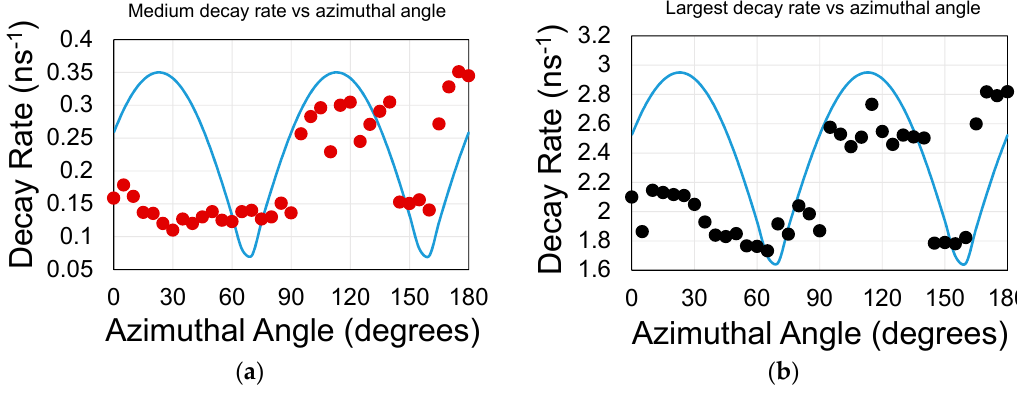
Figure 5. Sample S7. There are essentially two decay rate coefficients: ( a ) below and ( b ) above 1 ns − 1 . The blue line in ( b ) is a guide for the eyes (see SI Section). The curve was shifted by φ 0 since the initial hole-array orientation was unknown. The error in the decay rate fit was less than 1% (and hence is contained within a data point); the error in the azimuthal angle was 0.5°. The error in repeating the measurement of the same spot is less than 10%. In general, QDs, which are deposited on top of the graphene, exhibit clearer undulations.